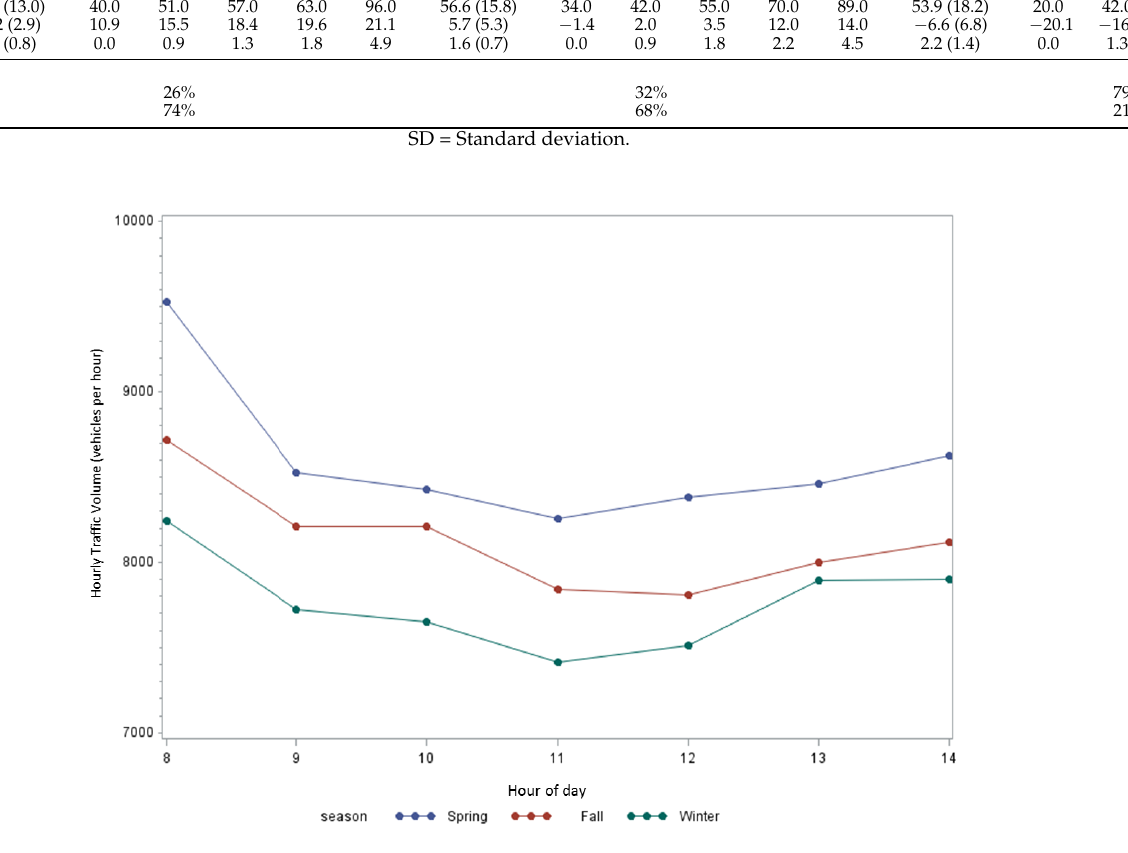
Figure 3. Hourly traffic volume on Interstate-85 separated by season.